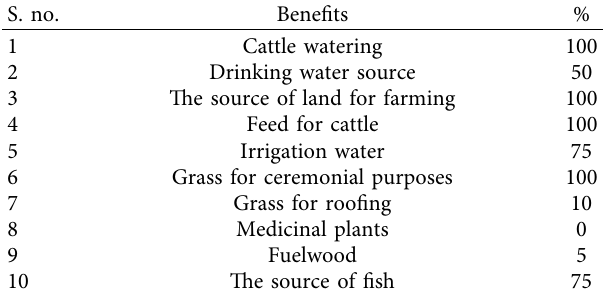
Table 4: Benefts of South Wollo wetlands for the local